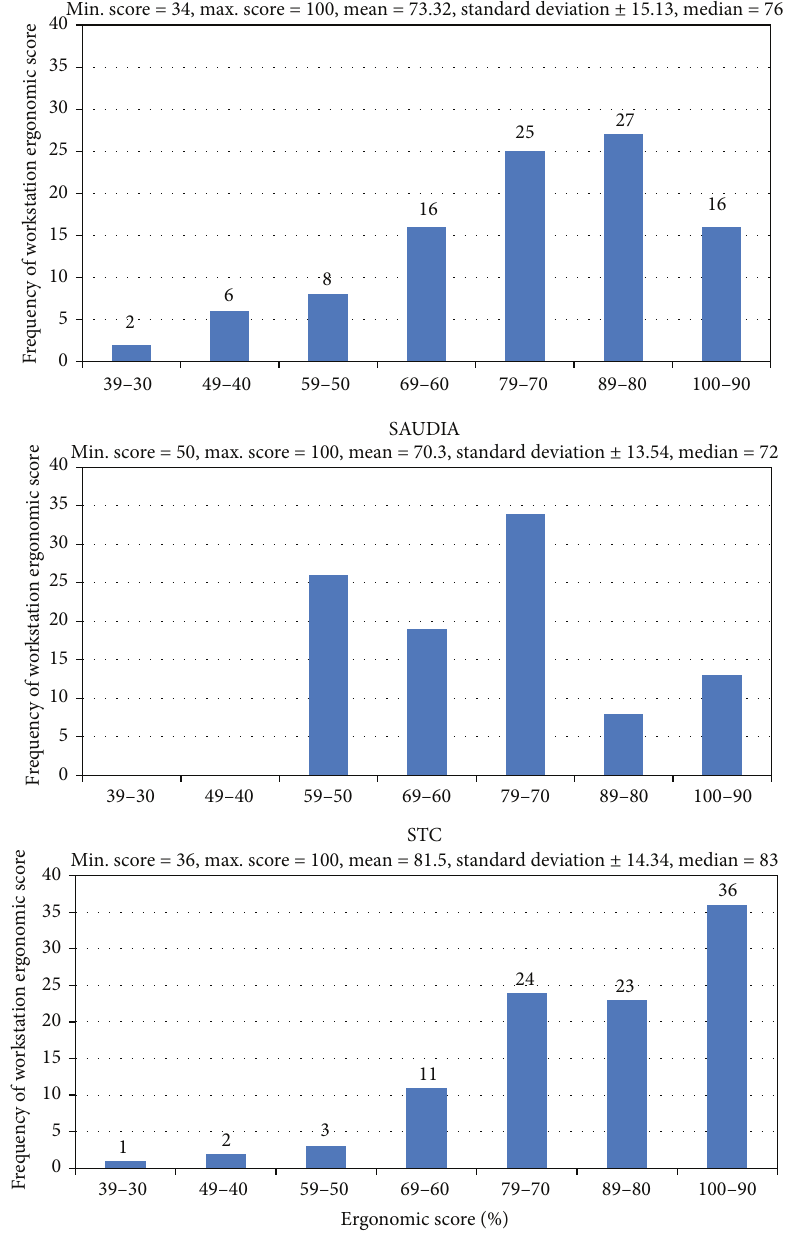
Figure 2: Distribution of the ergonomics scores of the examined workstation